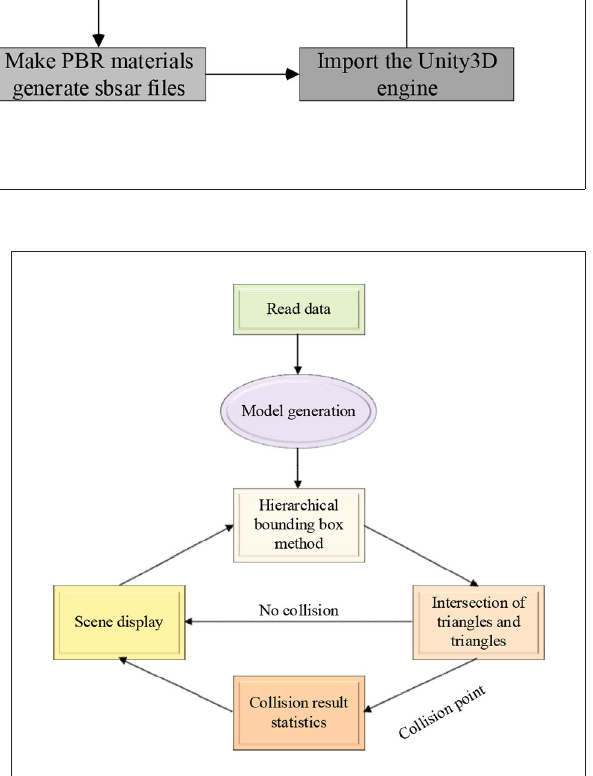
FIGURE3 The system framework of the collision detection